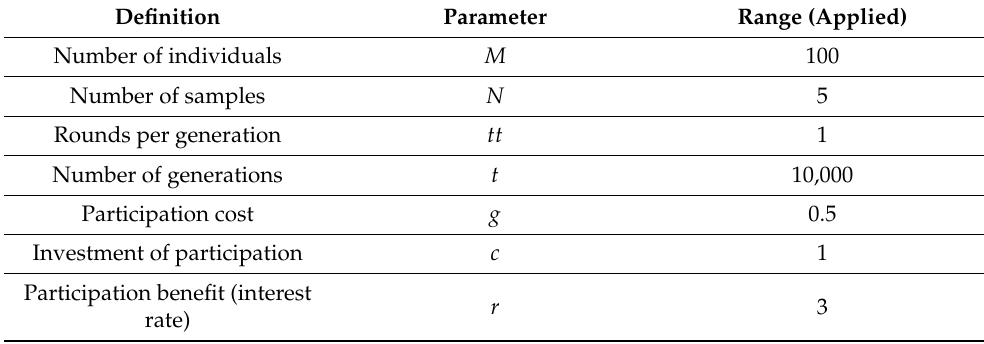
Table 3. Model variables (prototype), parameters, and default parameter values.